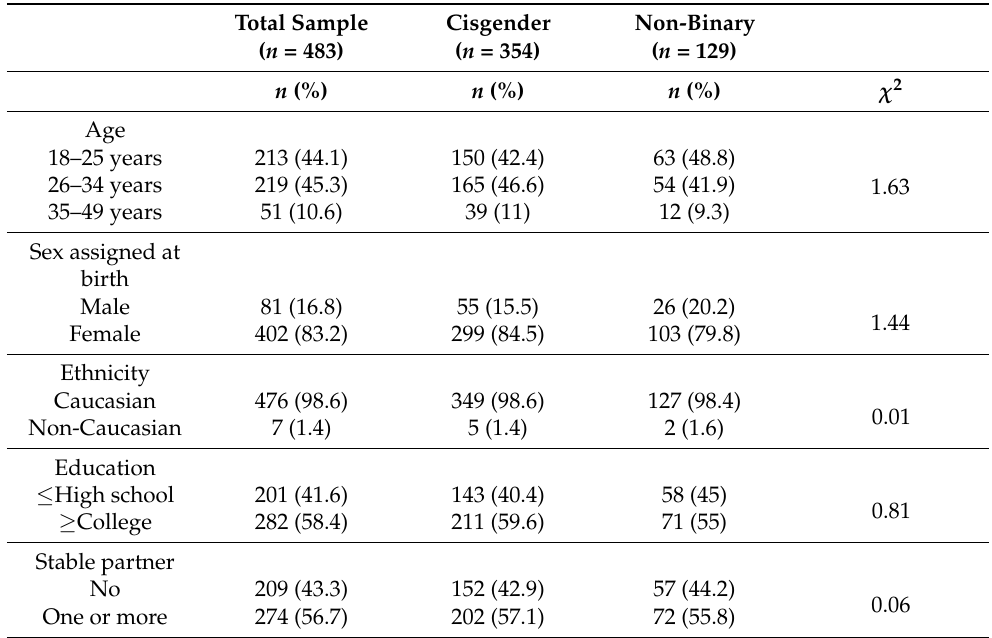
Table 1. Demographics of the